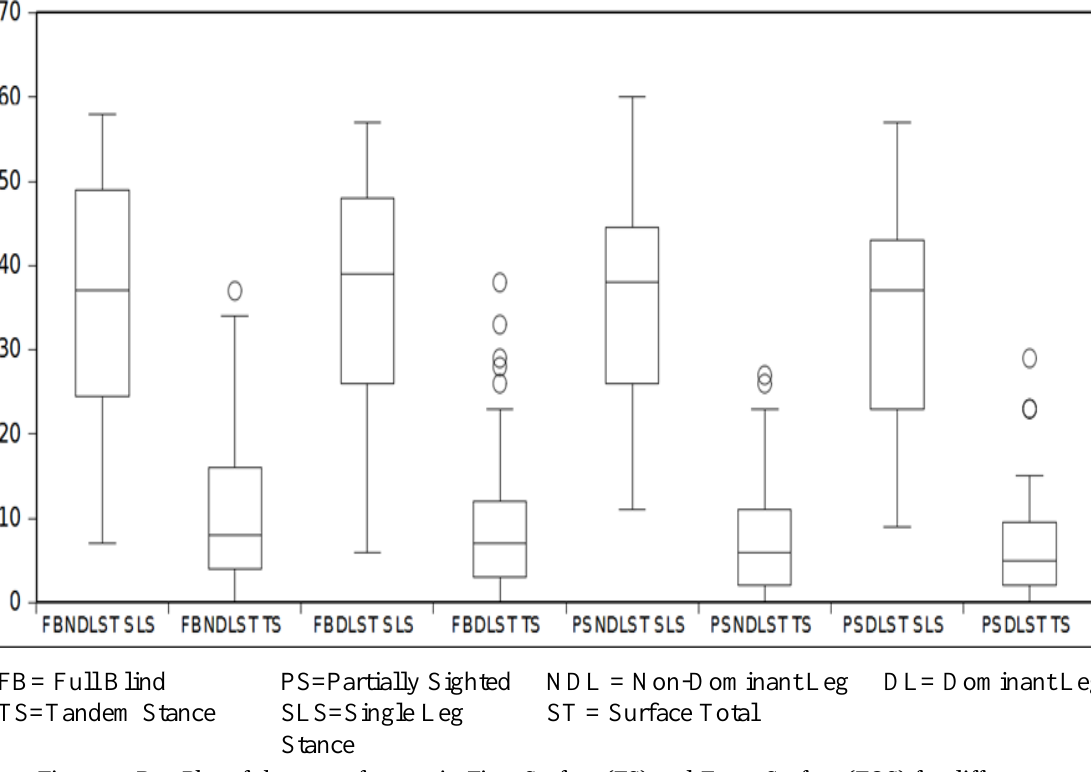
FB= Full Blind NDL = Non-Dominant Leg DL= Dominant Leg TS=Tandem Stance SLS=Single Leg ST = Surface Total Stance Figure 3: Box Plot of the sum of errors in Firm Surface (FS) and Foam Surface (FOS) for different dominance and stance conditions